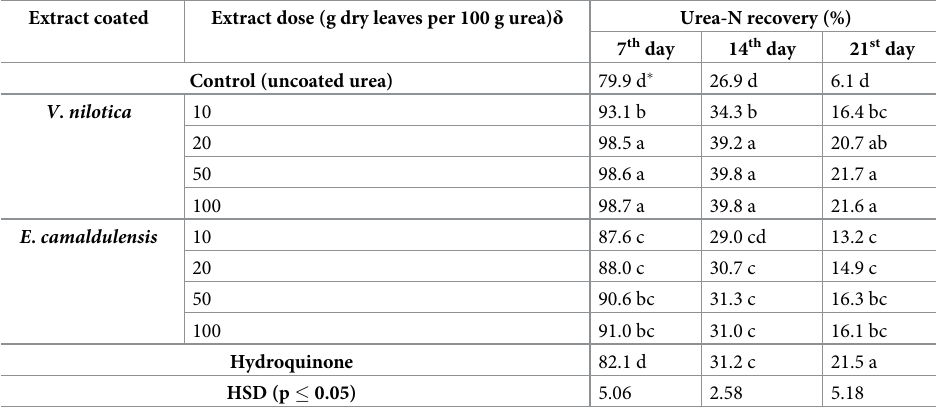
showed urease hydrolysis inhibitions of 24%, 22% and 20%, respectively, on average. Nicotiana tabacum showed 3.5% inhibition on average basis (Table 3). Having identified their potential of urease activity inhibition with the extracts of V . nilotica and E . camaldulensis , they were coated on urea prills and incubated with soil-1 for 21 days. The impact of extract coated urea on urea-N recovery at 7 th , 14 th and 21 st day of incubation (DOI) is presented in Table 4. In comparison to uncoated urea, application of V . nilotica extract coated urea significantly increased urea recovery at all three sampling times. Recovery of urea, coated with extract of 10 g dry leaves per 100 g urea, was 16, 27 and 168% more than Table 4. Percent recovery of urea-N from soil incubated with urea coated with leaf extracts of Vachellia nilotica and Eucalyptus camaldulensis . Extract coated Extract dose (g dry leaves per 100 g urea) δ Urea-N recovery